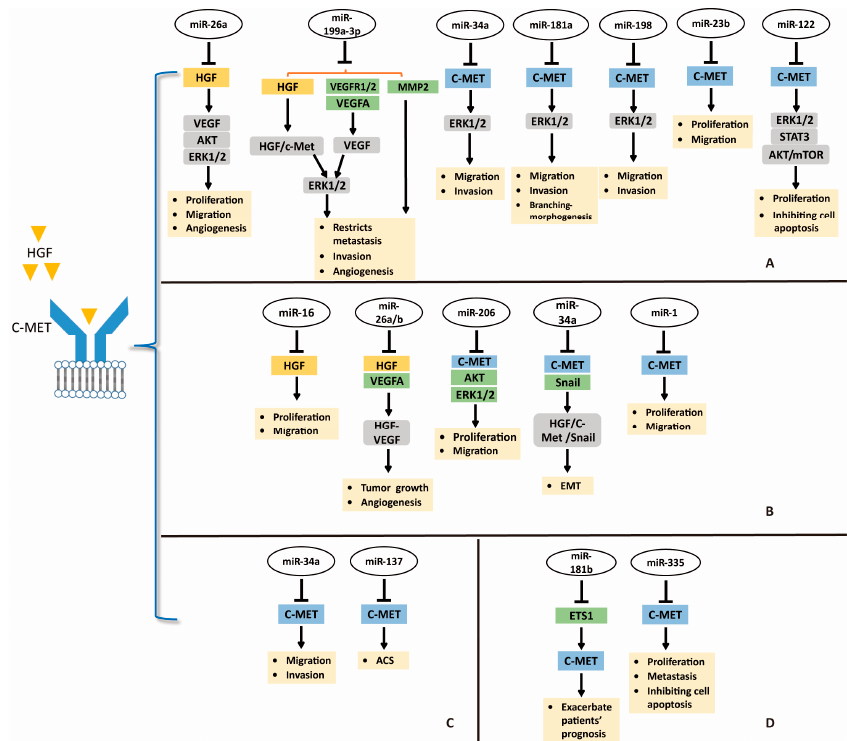
Figure 2. Targeting HGF/c-MET pathway in digestive system cancers by microRNAs. ( A ) targeting HGF/c-MET in HCC by miRNAs; ( B ) miRNAs-HGF/c-MET axis in gastric cancer; ( C ) miRNAs- HGF/c-MET axis in CRC; ( D ) miRNAs-HGF/c-MET axis and pancreatic cancer. Abbreviations: EMT, epithelial–mesenchymal transition; ACS, adenoma–carcinoma sequence. directly target;